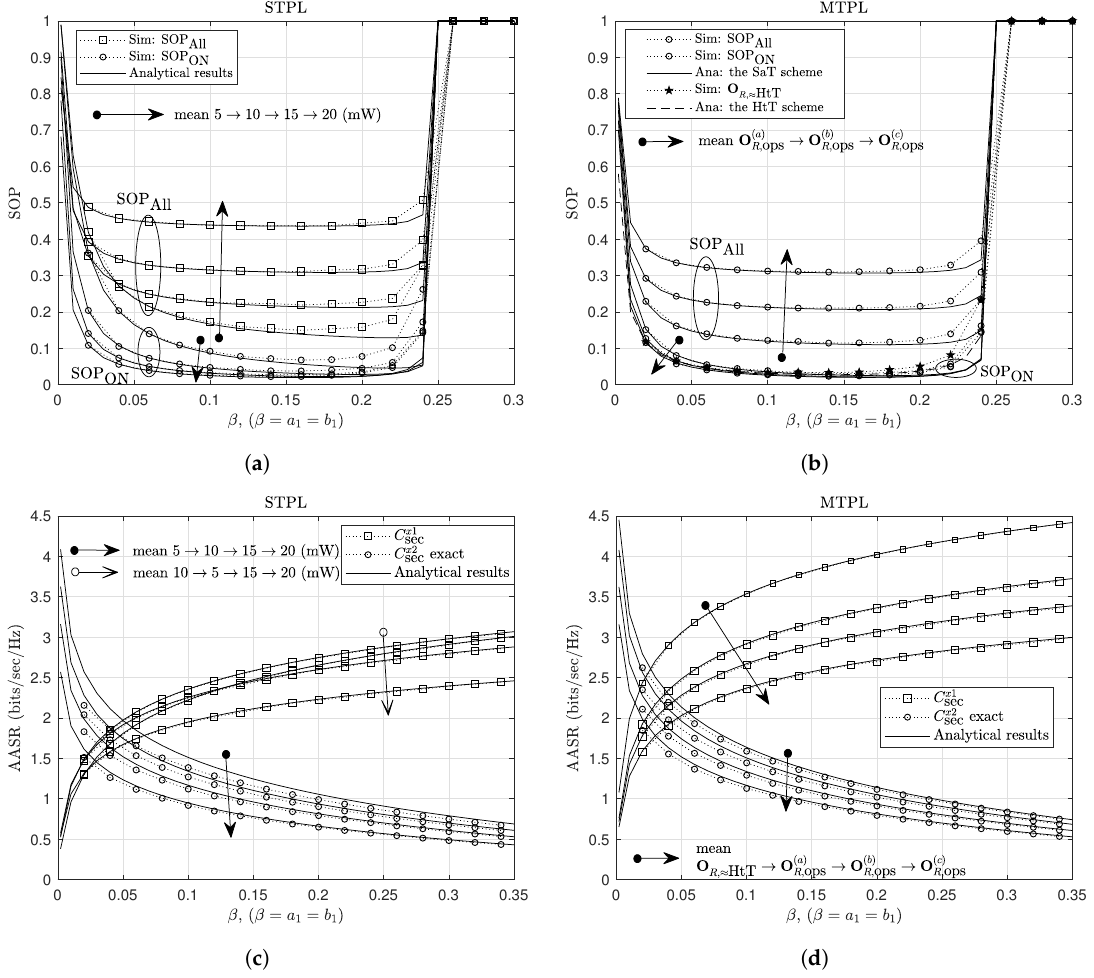
Figure 4. The effect of NOMA power-allocation factors on ( a ) the SOP for the STPL scheme, ( b ) the SOP for the MTPL scheme, ( c ) the AASR for the STPL scheme, and ( d ) the AASR for the MTPL scheme. Other parameters: J (1.5, −